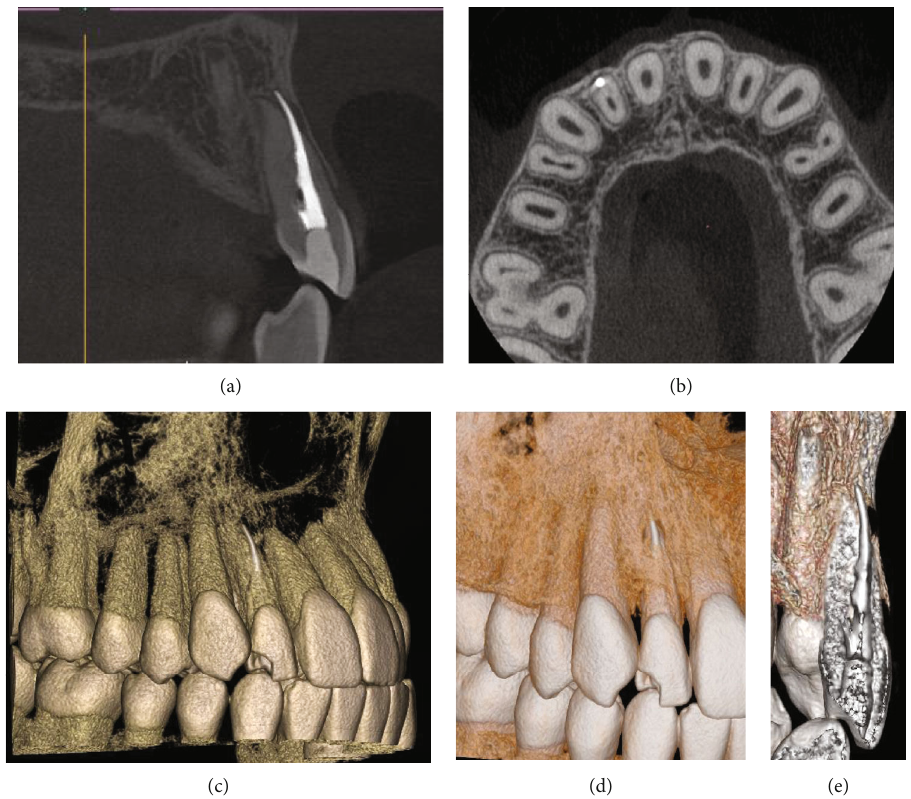
Figure 2: CBCT scans (a – e) and 3D reconstructions show sealing material out of the channel, extruded by root perforation in the middle third of the root